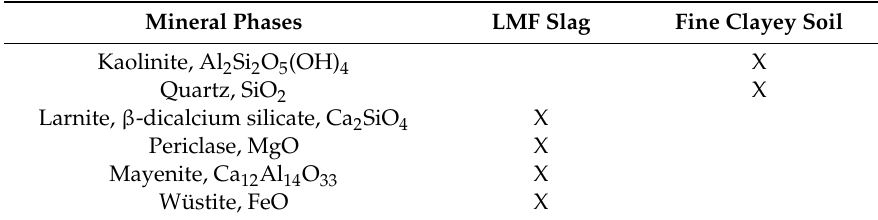
Table 4. Mineral phases identified by qualitative XRD.